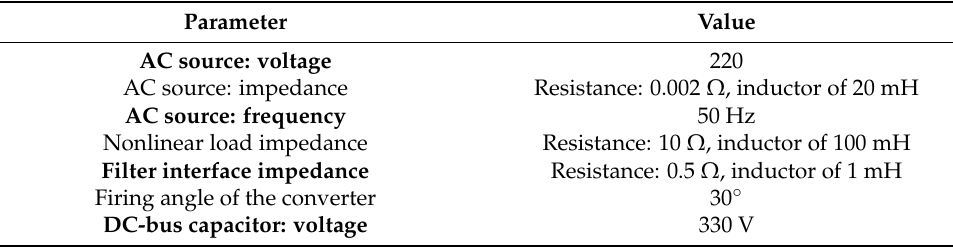
Table 1. System parameters for